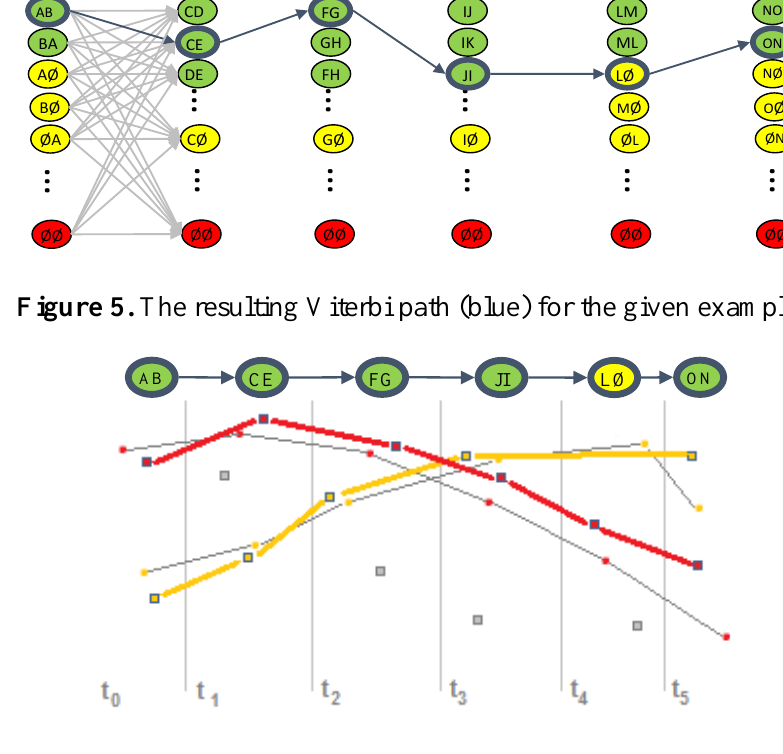
Figure 6. The trajectories (red, orange) are generated from the assignment tuples contained in the nodes of the Viterbi path. Some detections have been discarded (isolated gray